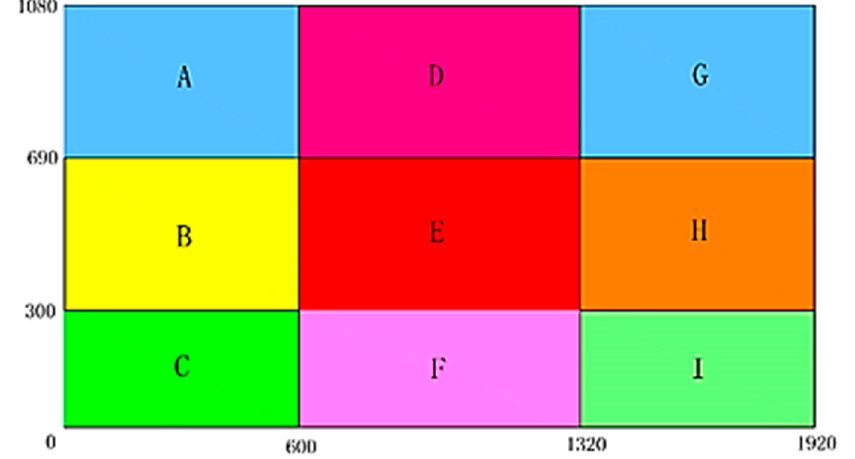
Figure 4. Area of Interest (AOI) division.